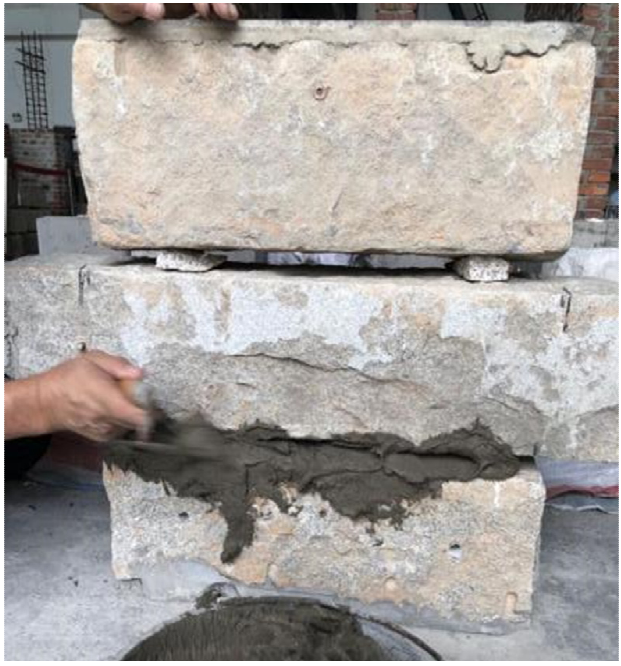
Figure 4. Filling the joints with mortar.